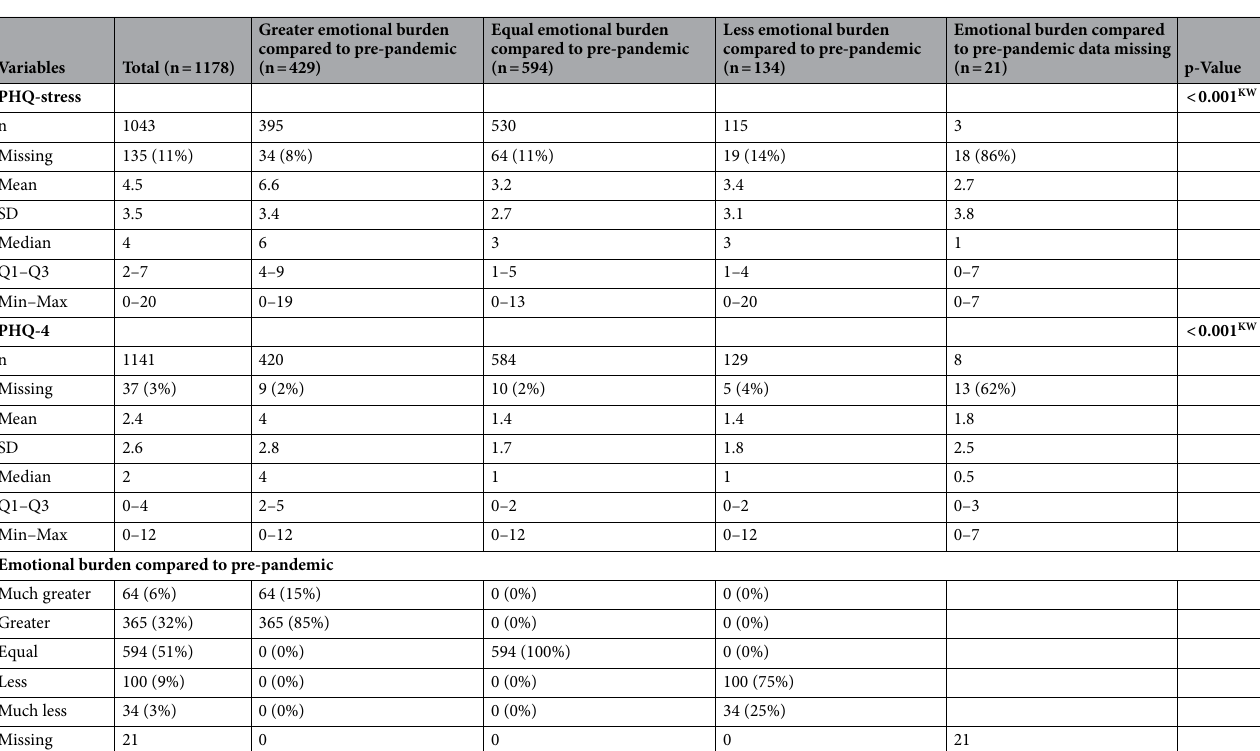
Table 3. Psychosocial factors. Significant values are in bold. All missing values were excluded for statistical testing. n number of participants, COVID-19 coronavirus disease 2019, SD standard deviation, Q Quartile, Min Minimum, Max Maximum, KW Kruskal–Wallis one-way